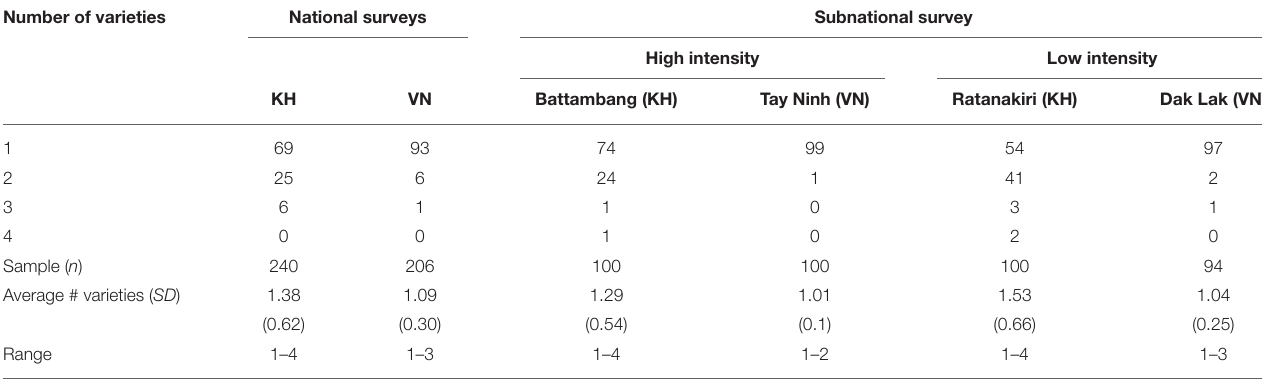
TABLE 2 | Number of varieties maintained at the farm level by producers in the 2016–2017 cassava season in both bi-national and subnational surveys (% respondents), with KH indicating Cambodia and VN indicating Vietnam. Number of